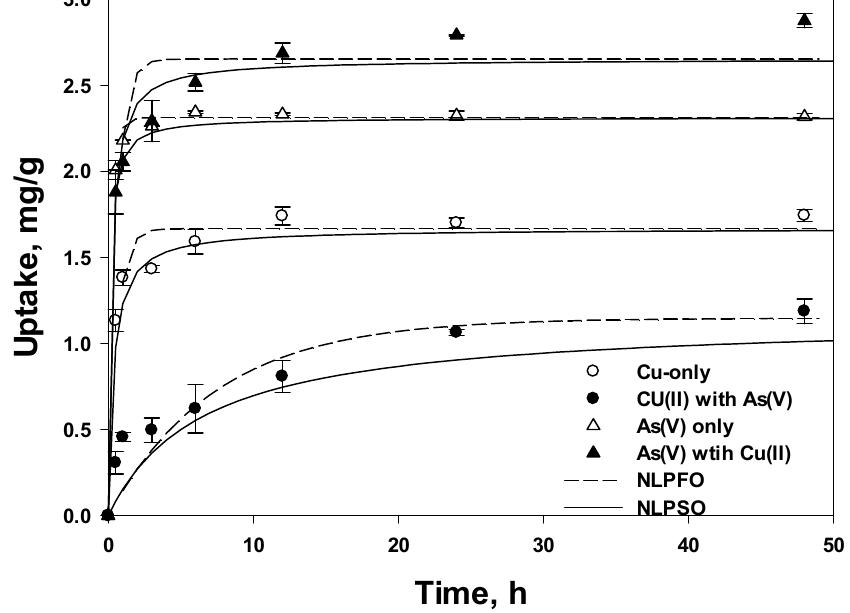
Figure 4. Nonlinear pseudo first-order (dots) and second-order (solid lines) kinetic models. Table 1. Kinetic parameters using nonlinear PFO and PSO models for Cu(II) and As(V) in single and mixed